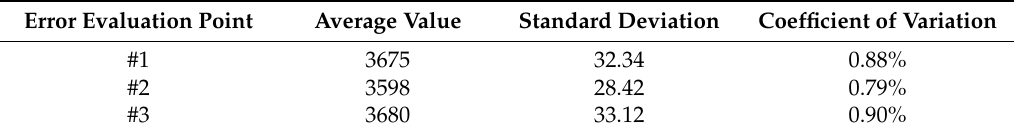
Table 1. The calculated results of the sample parameters.